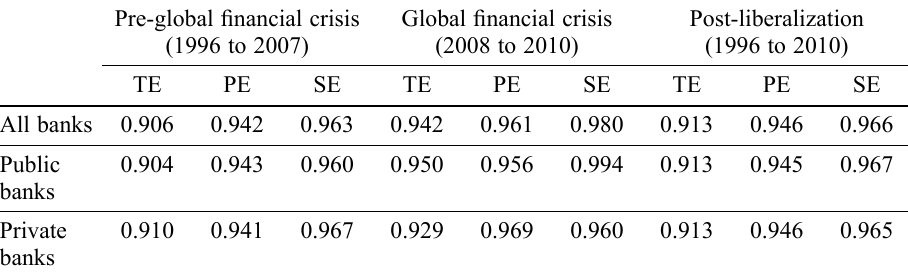
Table 3. Summary statistics of technical efficiency and its components in different